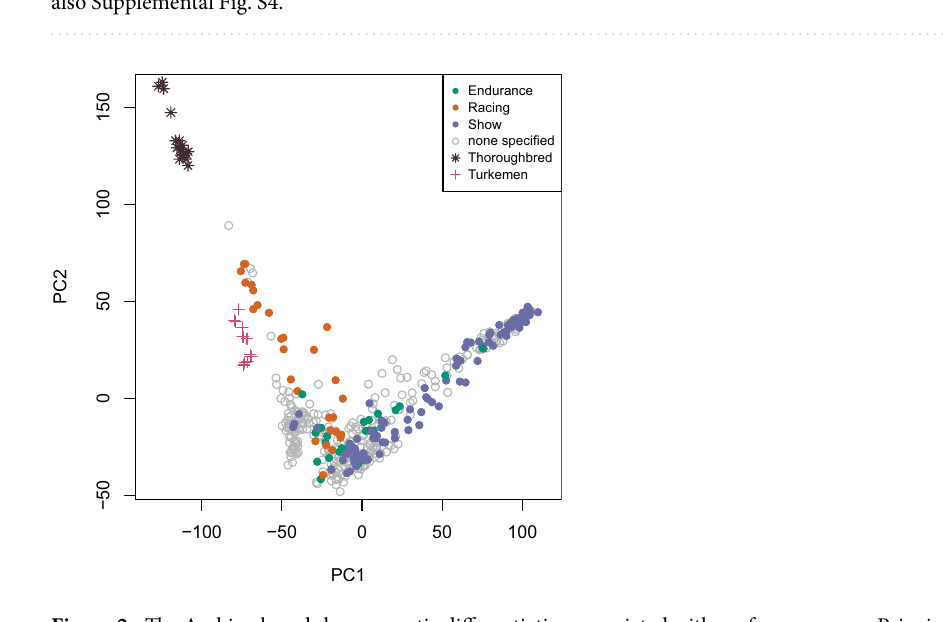
horses of the Straight Egyptian lineage are used only for show competitions. Horses used for endurance races tended to be drawn from the Polish and multi-origin clusters. Finally, many of the Arabian horses used for flat racing were placed in PC space closer to the Thoroughbred cluster (Fig. 2). This relationship may have historical significance and warrants further investigation. Structure. We described evidence of global shared ancestry using the STRUCTURE program 25 within the same collection of horses visualized by PCA in Fig. 1B (after pruning for relatedness [IBD < 0.25] to 296 animals).